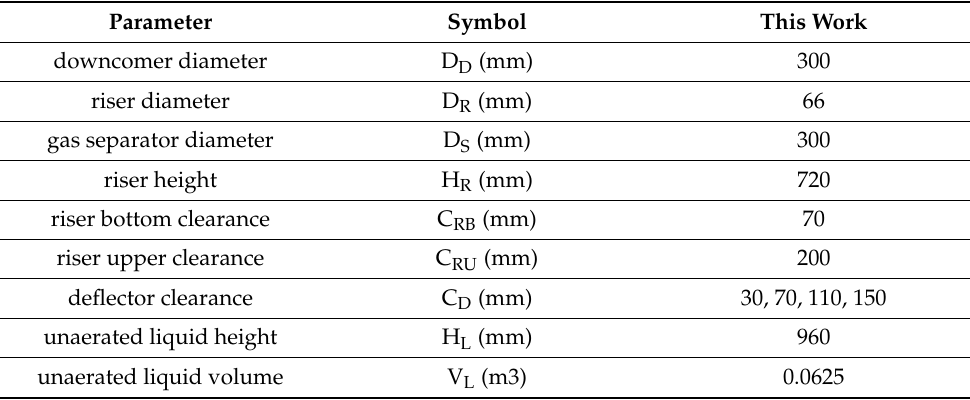
Table 5. Concentric jet-loop airlift bioreactor: Geometrical